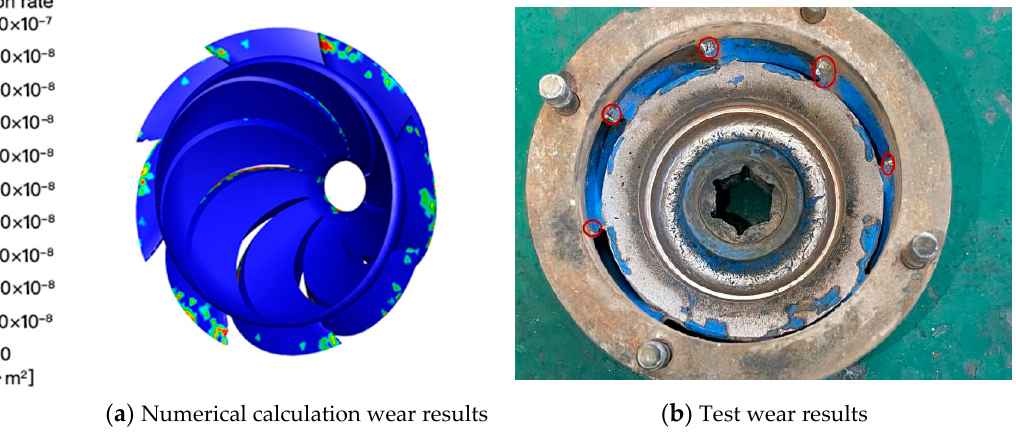
Figure 29. Comparison of the wear at the secondary guide vane.